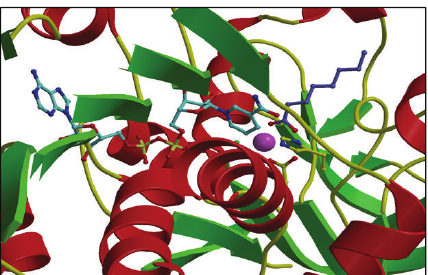
Figure 5: A ribbon diagram highlighting the details of the active site of the Aeropyrum ADH enzyme showing the catalytic zinc ion as a sphere together with the bound cofactor NADH and an enzyme inhibitor in stick mode, defining the substrate-binding pocket (PDB code 1H2B). The figure was constructed using CCP4mg